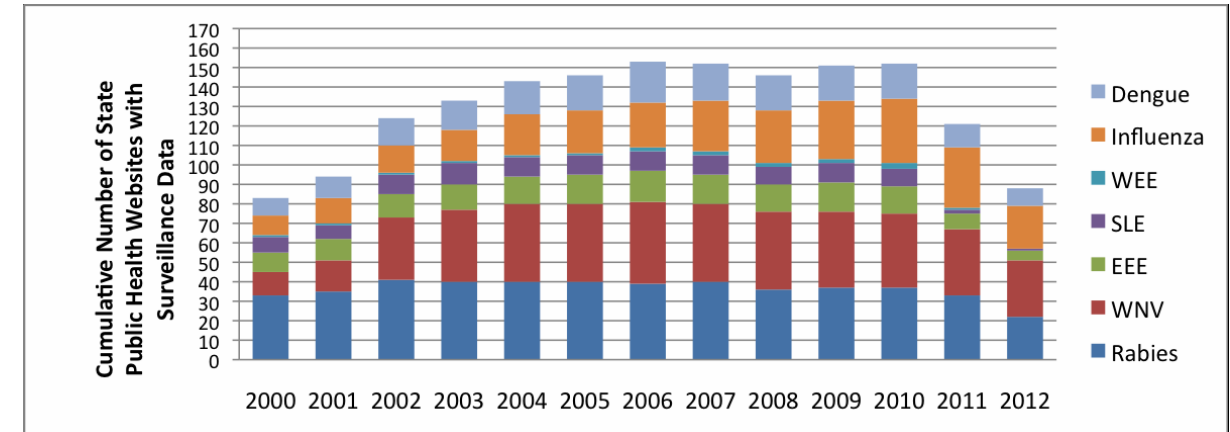
Figure 2. Cumulative number of state public health websites with surveillance data, by virus and year.